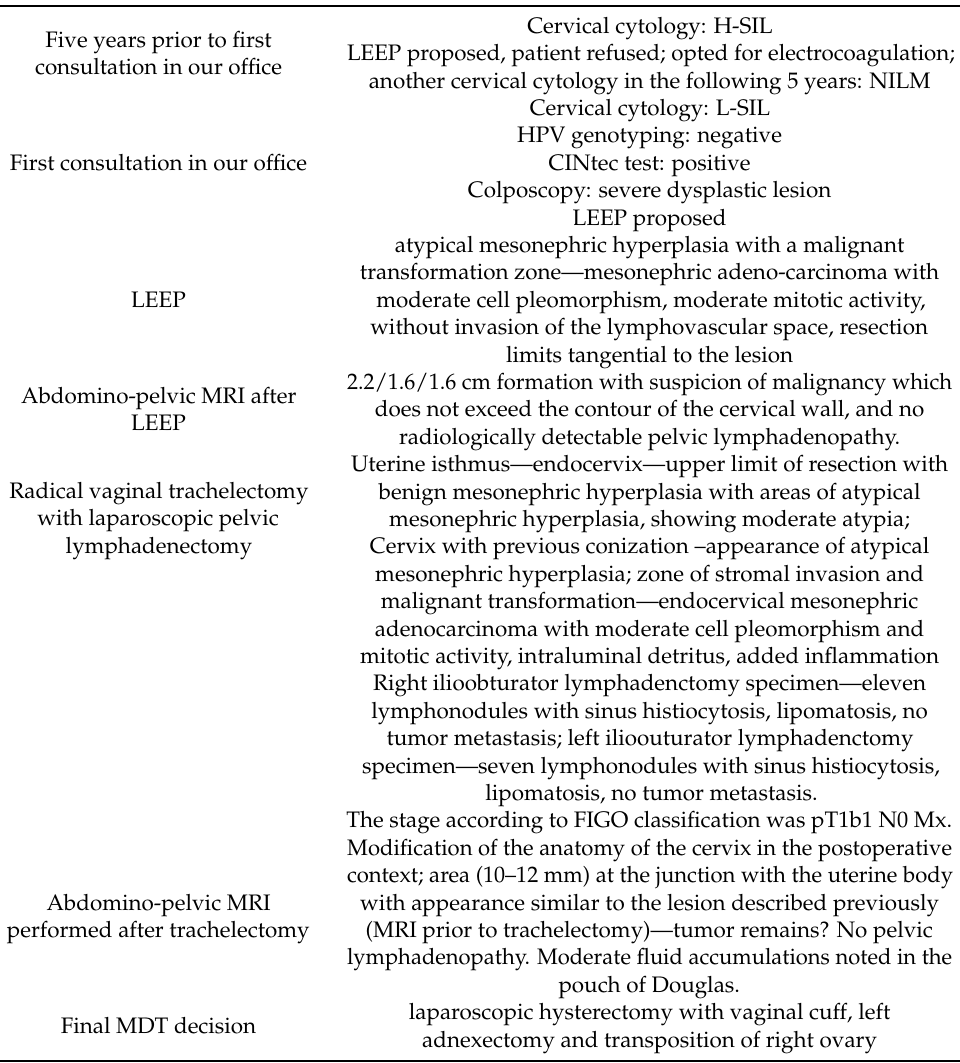
Table 2. Schematic presentation of investigations, pathophysiological and etiological information including treatment history of the case. Abbreviations: H-SIL = high grade squamous epithelial lesion; LEEP = loop electrosurgical excision procedure; NILM = negative for intraepithelial or malignant lesions; L-SIL = Low-grade squamous intraepithelial lesion; HPV = human papilloma virus; CINtest = dual staining p16/Ki-67 MRI = magnetic resonance imaging; MDT = multidisciplinary team; HPV = human papilloma virus; CINtest = dual staining